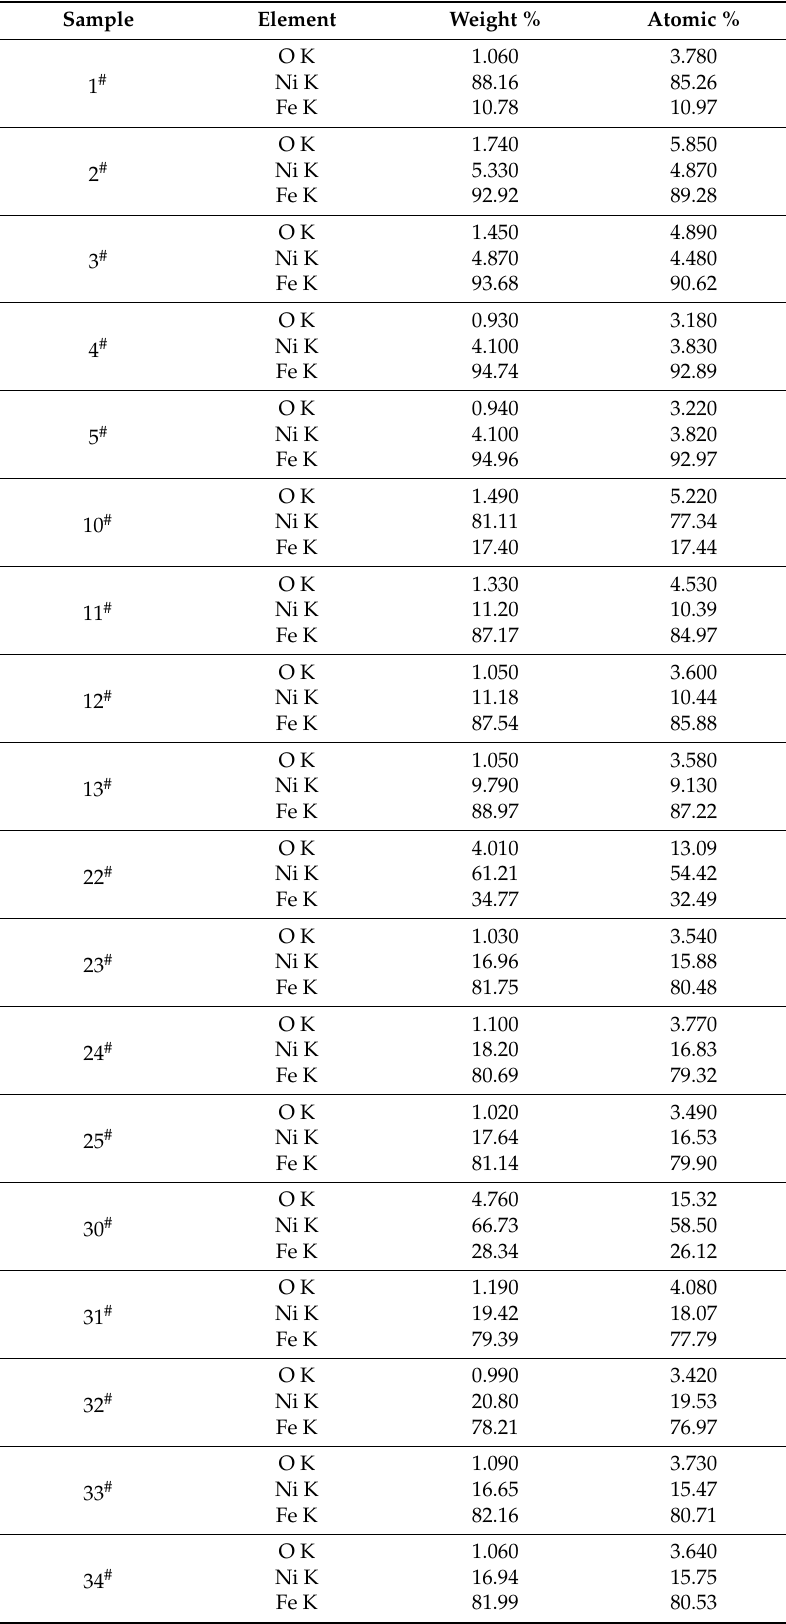
Table 1. Chemical composition of the Fe–Ni